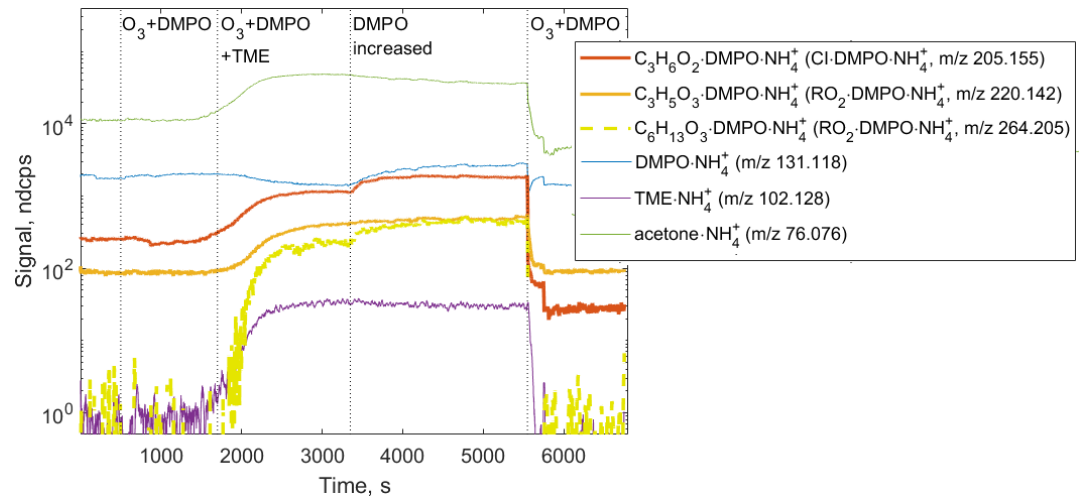
Figure 6. Ion tracers observed by NH + CIMS in a TME ozonolysis experiment as a function of the reactant conditions. Reactant concentra- 4 tions are [TME] = 3 . 69 × 10 11 ; [ O 3 ] = 7 . 87 × 10 12 ; [ DMPO ] = 2 . 01 × 10 12 moleculecm − 3 .